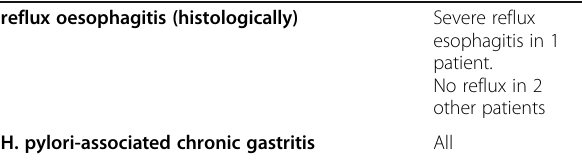
Table 2 Correlation between EE as an ordinal variable and dichotomous study variables Study variable